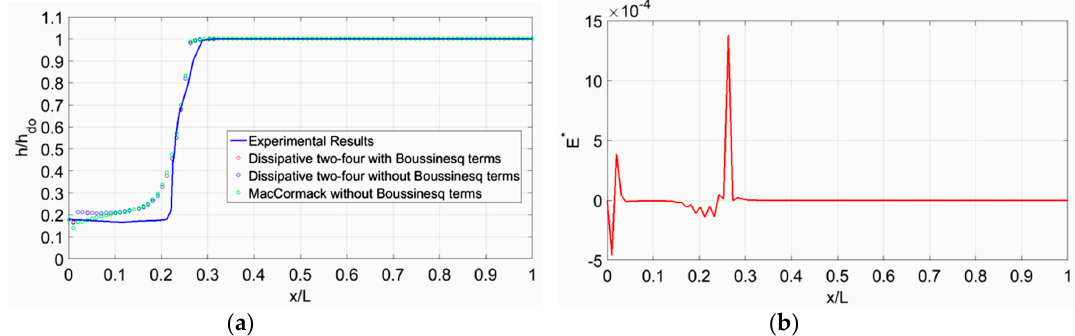
term versus distance.